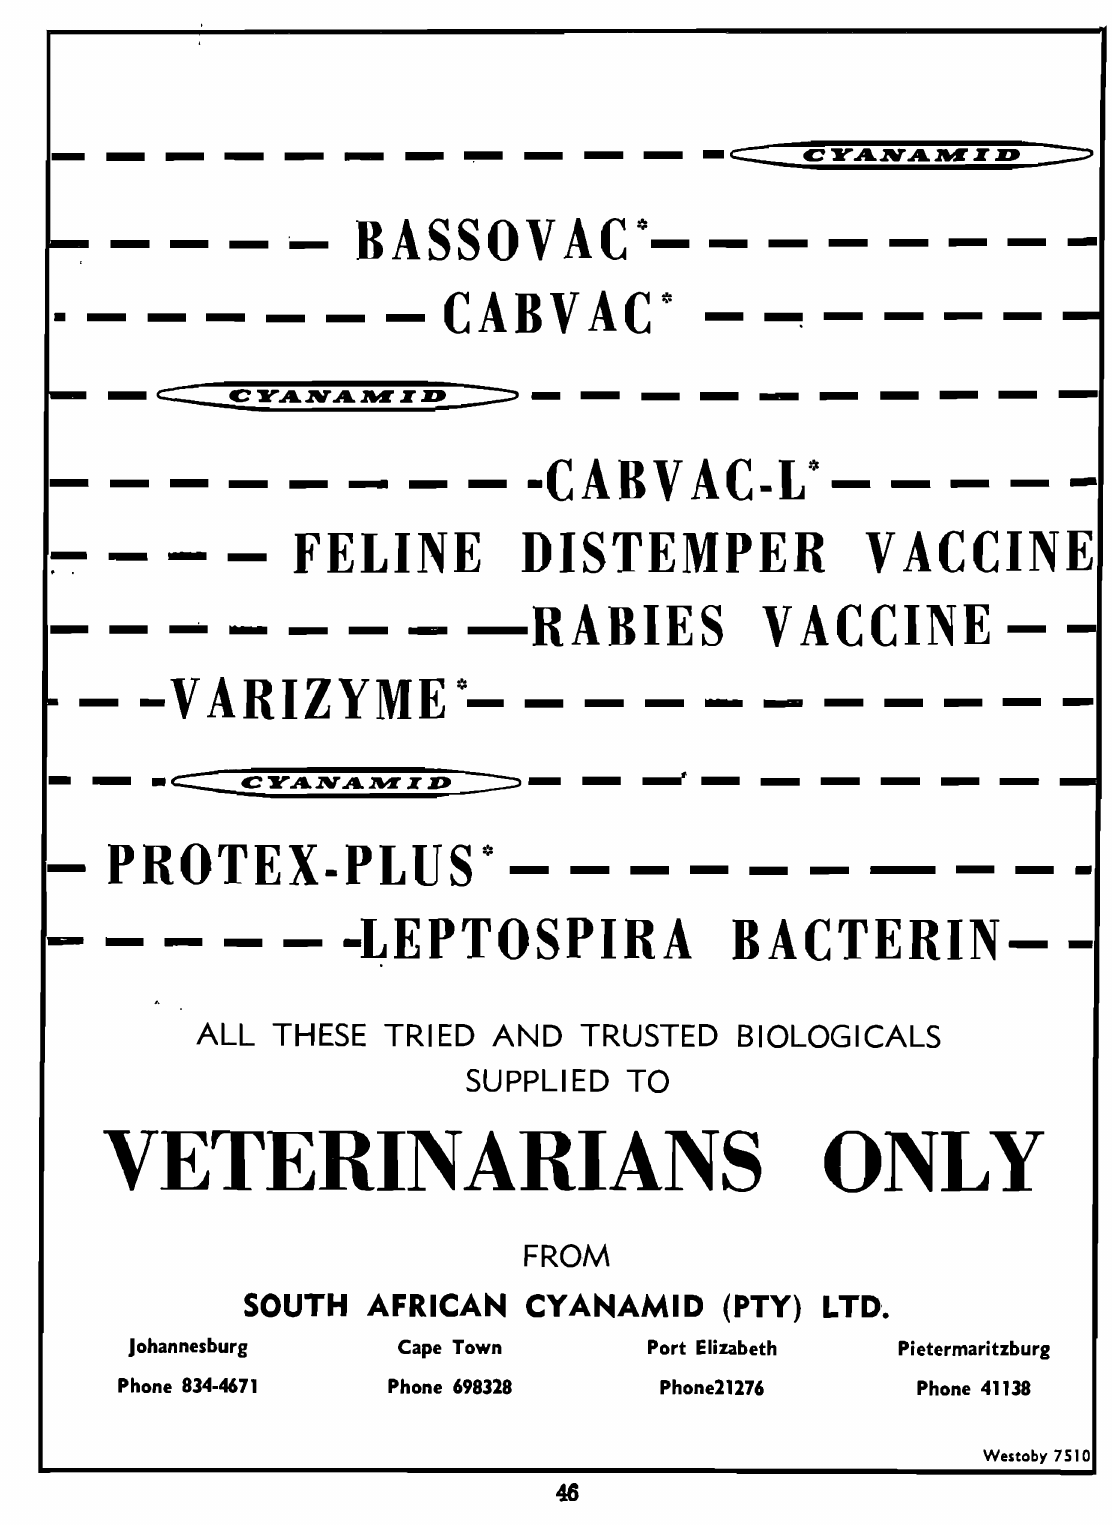
FELINE DISTEMPER VACCINE - - -RABIES VACCINE- -VARIZYME*- - - - - - - - - - - - - - - - - -